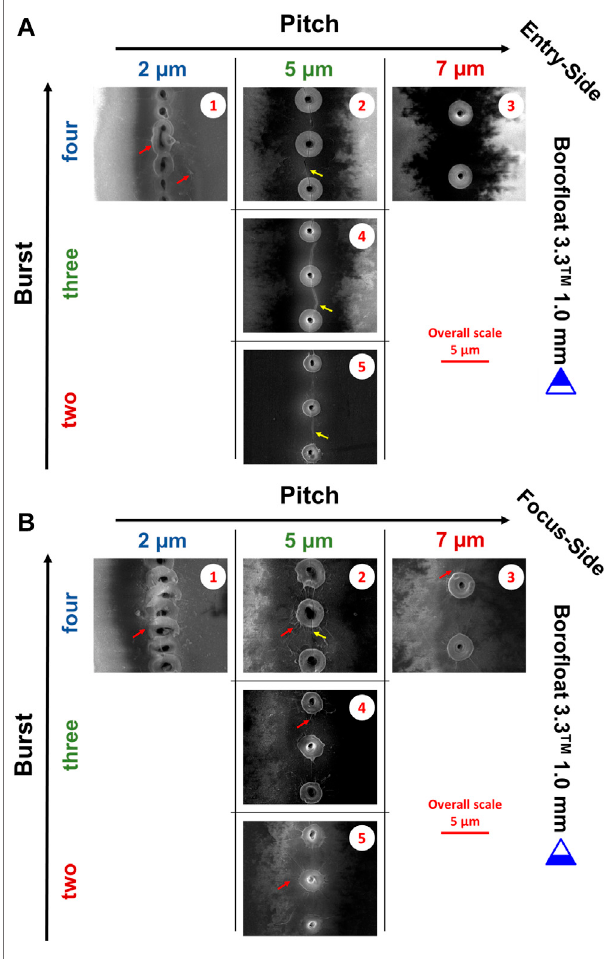
FIGURE 3 | The SEM images of the Entry-Side (A) and of the Focus-Side (B) of Boro fl oat 3.3 ™ 1.0 mm samples. Pitch is increasing from left to right and number of pulses within one Burst from bottom to top. The scale bar is attached to the right of the images. Numeration in the top right corner is set to better address speci fi c image. Surface modi fi cations show partially strong melting and overlapping but also discrete round regular shapes and fi ne sprinkles (red arrows). Continous surface cracks are indicated by yellow arrows. Charge effects in the surrounding material might be related to nano fragmented recondensed liquid